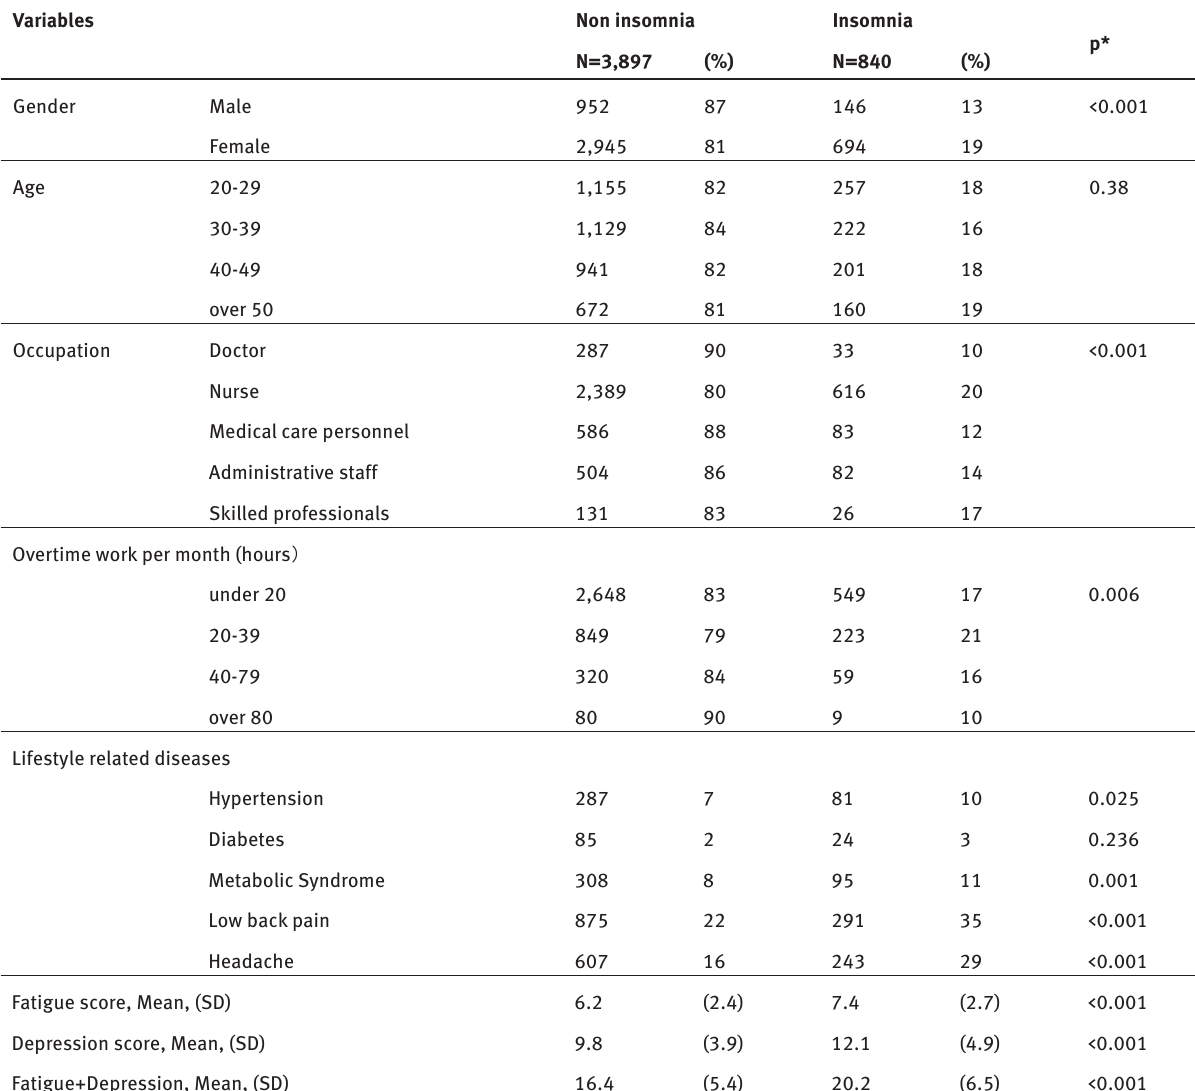
Table 1: Demographic characteristics by existence of sleeping disorder